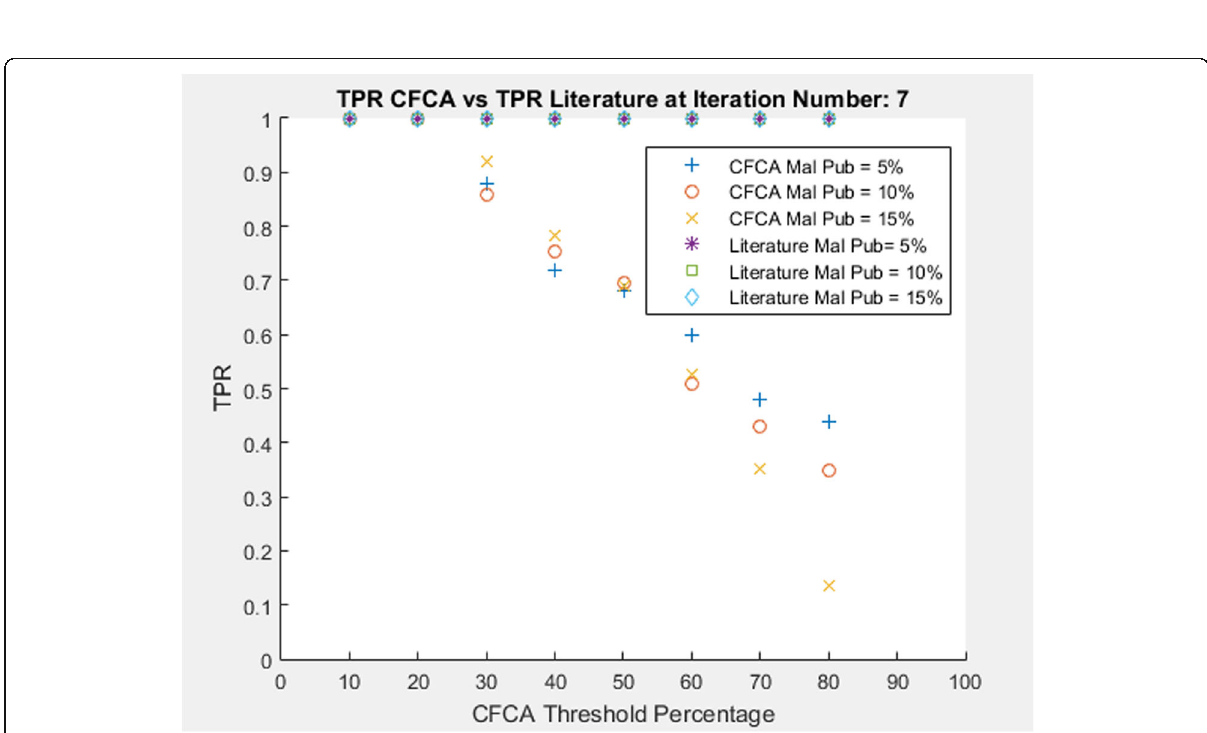
Fig. 10 TPR CFCA vs TPR literature at iteration